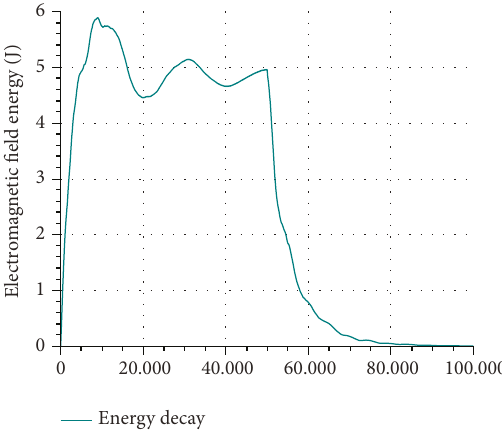
Figure 18: Energy decay as a function of time for indoor propagation. We observe the accurate dissipation of energy due to the presence of the CPML ABC, after the source is turned o ff at n = 50, 000 time